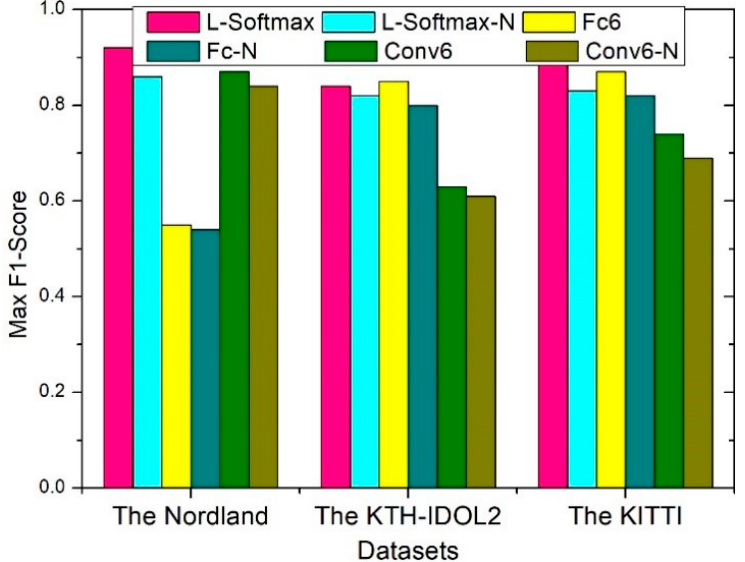
Figure 12. Different middle-end components show different performance. Six kinds of structures are sorted into three groups, in which each group has the same structure except middle-end. In each group, one has Inception-A modules and another one has no Inception-A module. For example, L-Softmax has Inception-A modules, and L-Softmax-N does not have Inception-A modules.